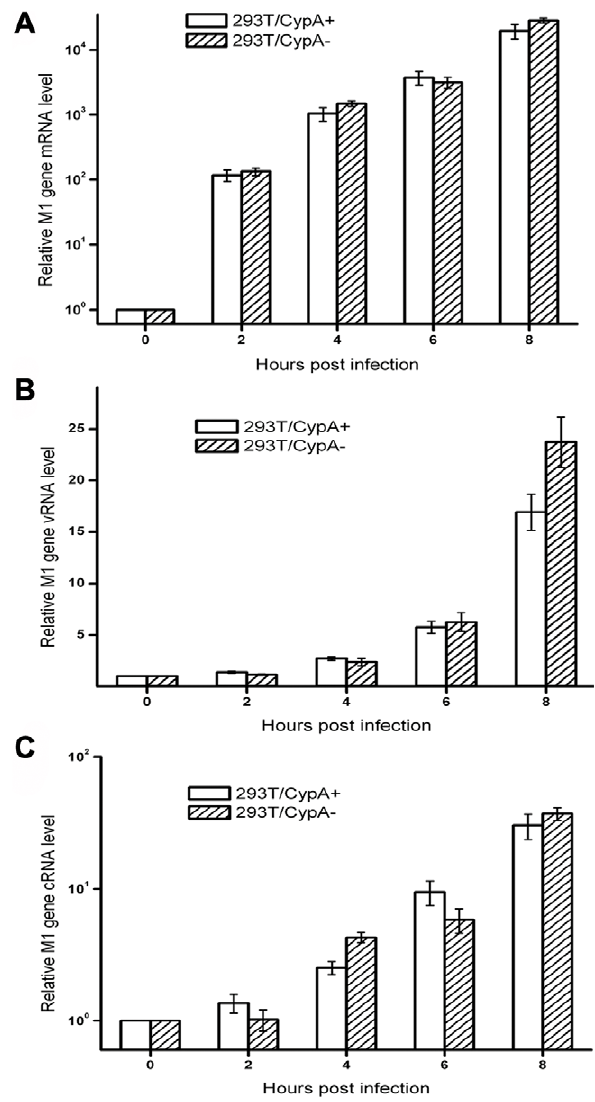
Figure 3. CypA suppressed influenza virus replication at the post-transcription level. Relative quantitation of M1 mRNA (A), vRNA (B), and cRNA (C) in cells infected with A/WSN/33 at different time points post-infection. As described in the experimental procedures, different primers were used for the cDNA synthesis of mRNA, vRNA, and cRNA. Comparison of viral RNA levels from influenza A M1 genes in the presence or absence of CypA. The specificities of the amplified products were all confirmed by melting curve analysis. In all of the PCR assays, GAPDH was used as an internal control. Data are means 6 SD of three separate